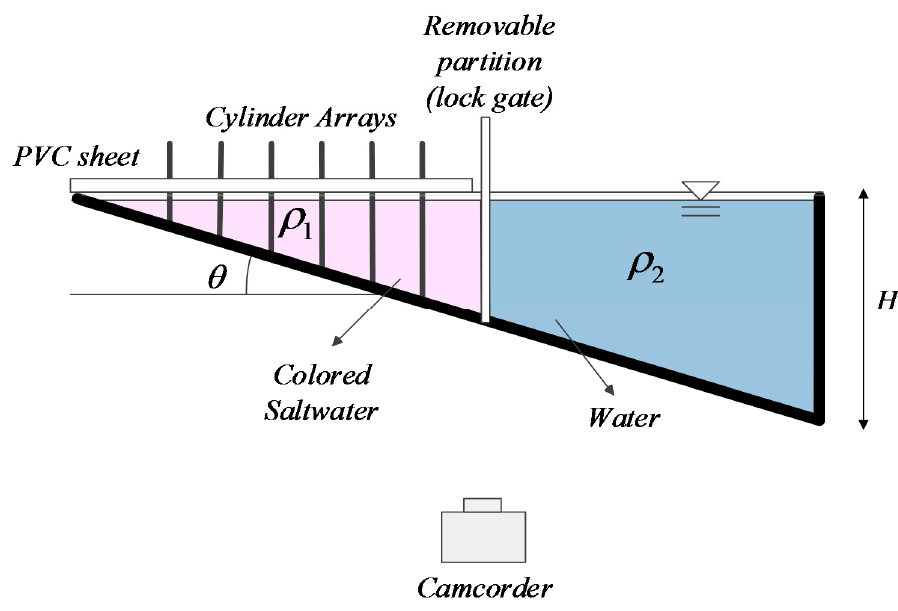
Figure 2. Set-up of a lock-exchange experiment with a model canopy distributed in a shallow region.